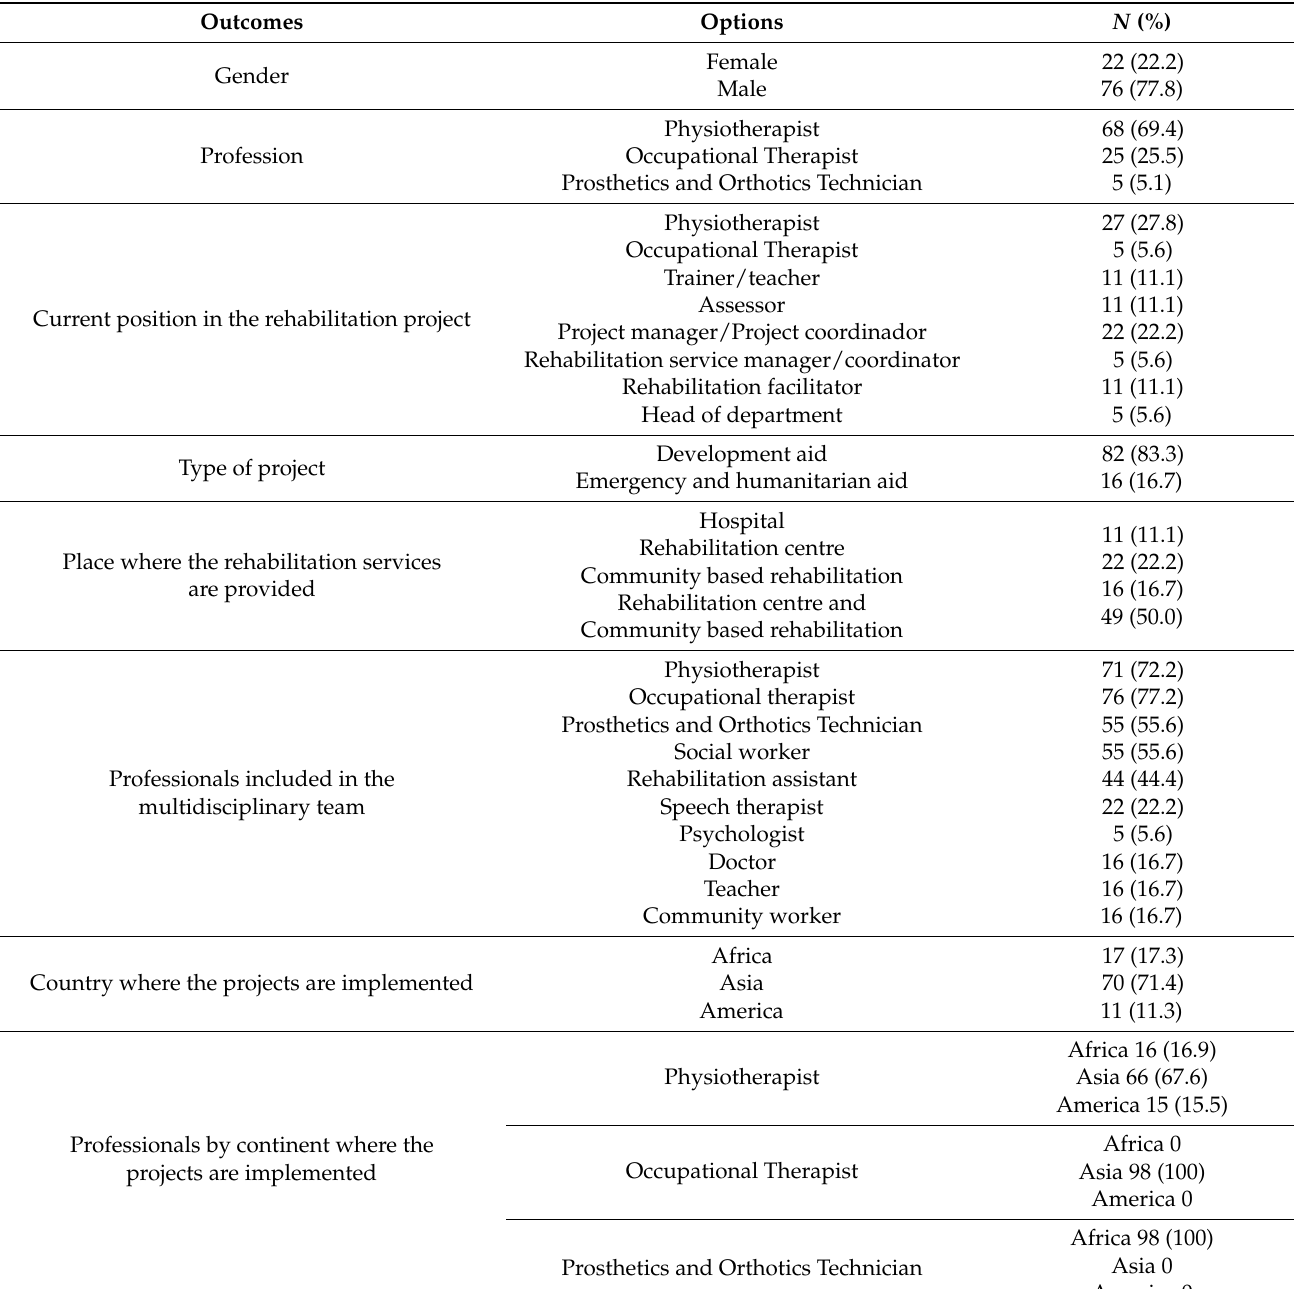
Table 1. Socio-demographic and professional